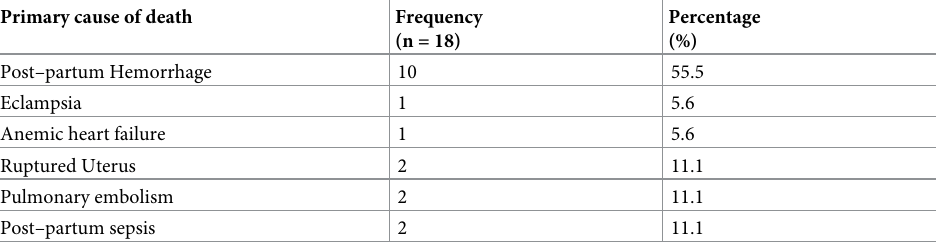
Table 2. Obstetric causes of maternal deaths at Central Hospital, Benin City.